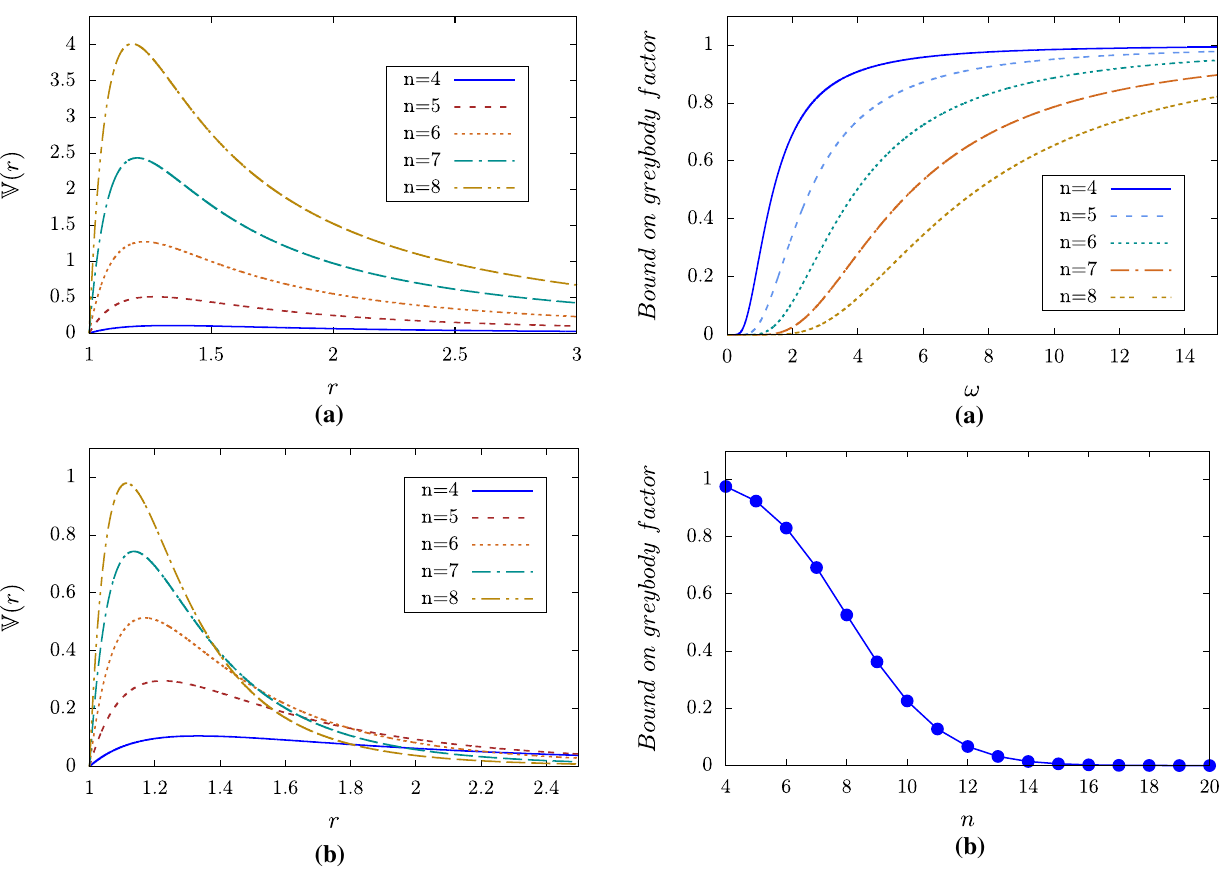
Fig. 1 a Plot of the potential V ( r ) corresponding to a scalar field in the bulk with respect to the radial coordinate r for l = 0, r H = 1 and different dimensionality n . b Plot of the potential V ( r ) corresponding to a brane-localized scalar field with respect to the radial coordinate r for l = 0, r H = 1 and different dimensionality n